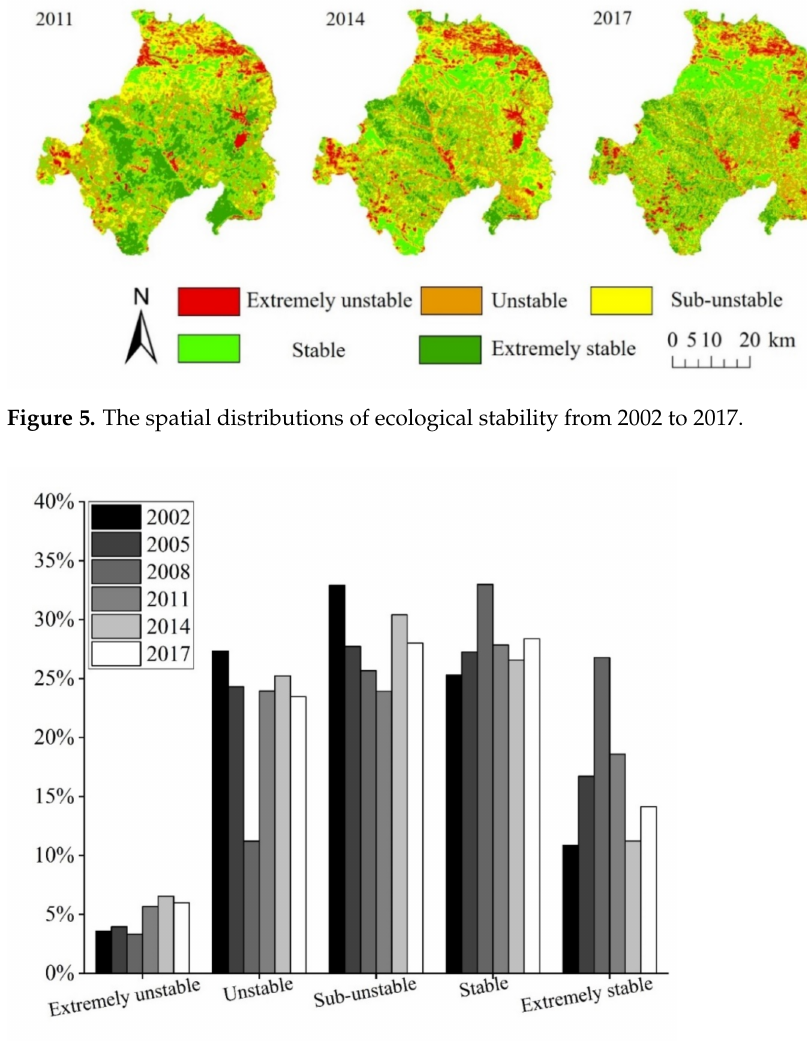
Figure 6. Percentages of different ecological stability grades from 2002 to